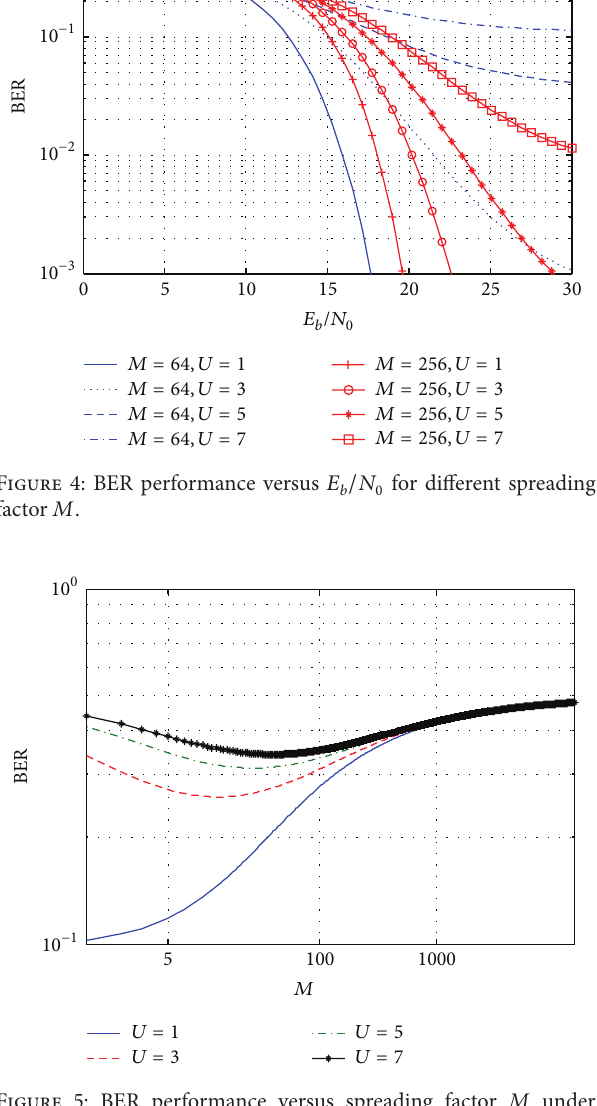
Figure 5: BER performance versus spreading factor 𝑀 under /𝑁 = 𝐸 𝑏 0